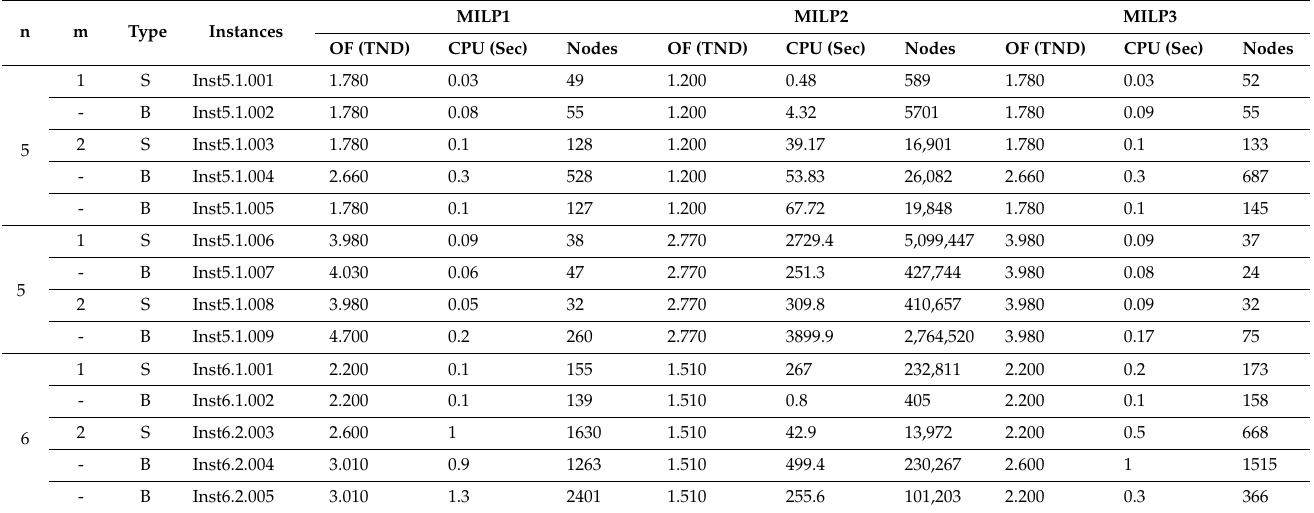
Table 1. Low demand and customers number instances.